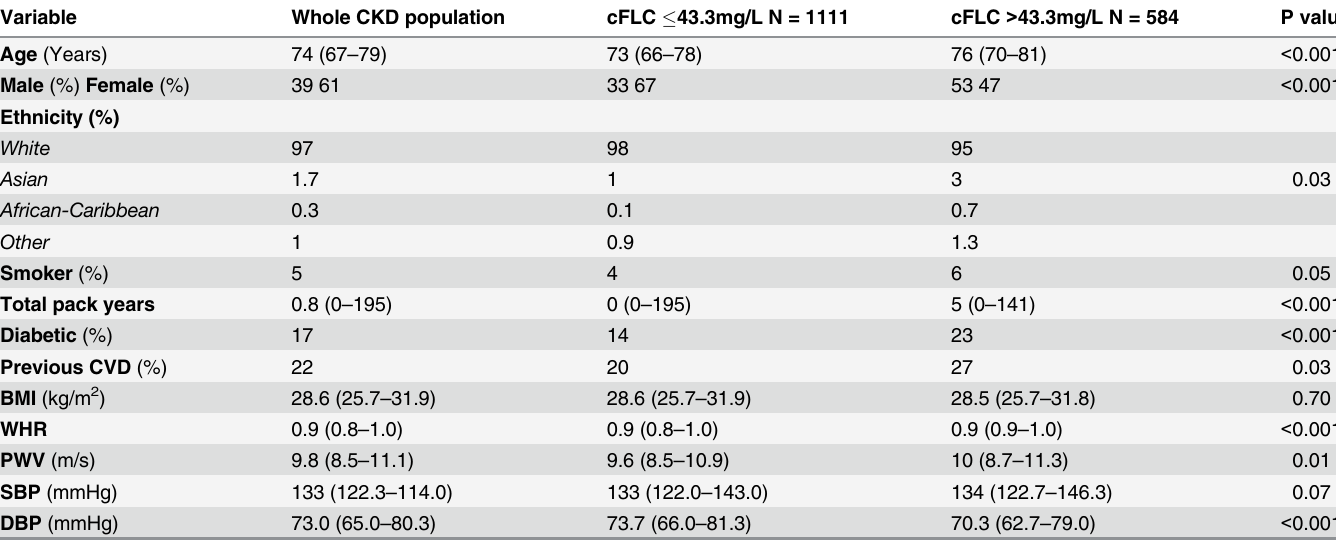
Table 1. Baseline patient demographics and clinical variables in relation to serum cFLC